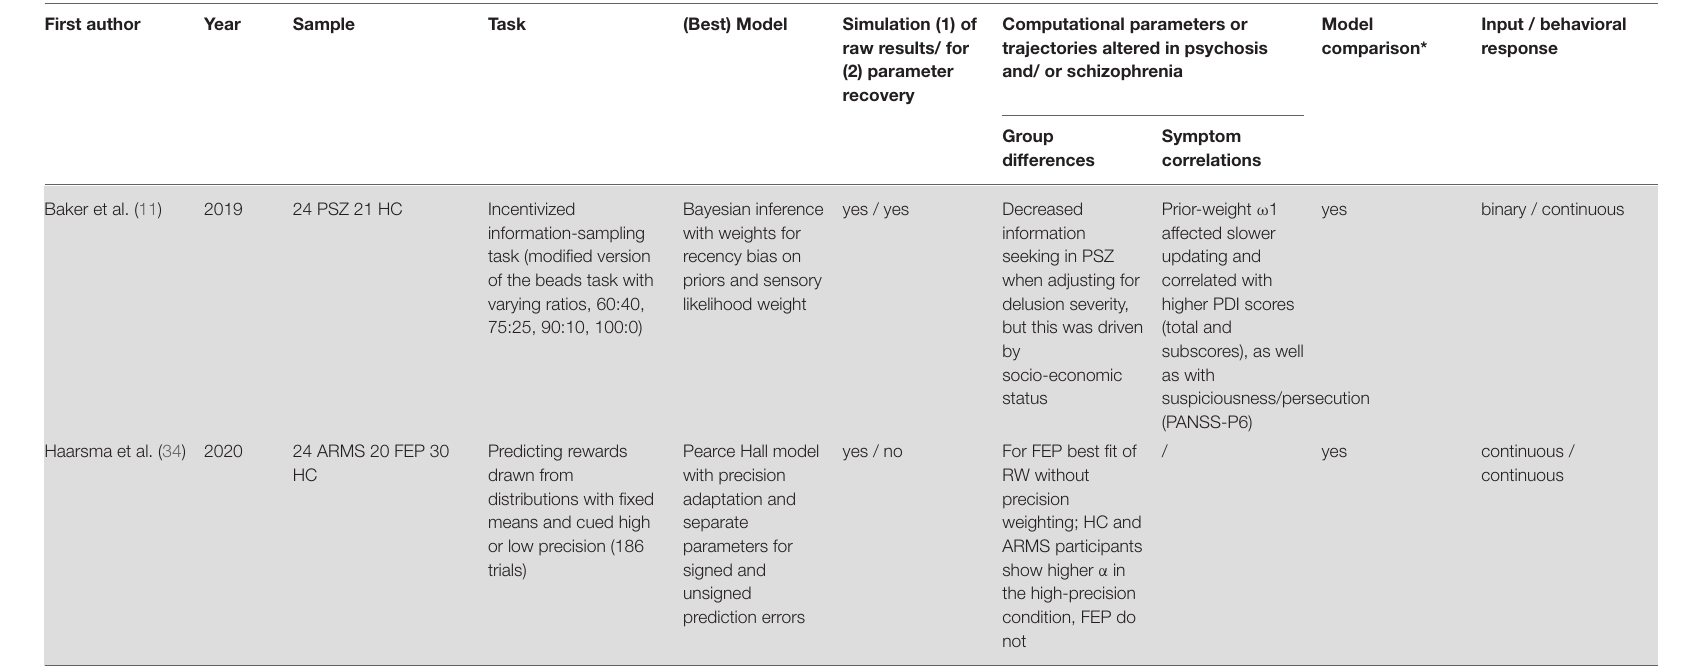
Hierarchical Gaussian Filter models in green, Change point detection modeling in yellow, Selection of various other dynamic models in grey. ARMS, At Risk Mental State; CHR, Clinical High Risk; FEP, First Episode Patients; HC, Healthy Controls; HP, High Paranoia; LP, Low Paranoia; PSZ, Patients with Schizophrenia; RLT, Reversal Learning Task; DU, Double Update; HGF, Hierarchical Gaussian Filter; HMM, Hidden Markov Model; RW, Rescorla-Wagner; V, Volatility; PANSS, Positive and Negative Syndrome Scale; PDI, Peters Delusion Inventory; Computational parameters or trajectories: α , learning rate; β , softmax temperature; δ , prediction error; k, 2 nd and 3 rd level coupling (HGF models); µ 3, dynamic volatility belief; ω , constant component of 2 nd level belief update/evolution rate; ϑ , meta-volatility; m3; mean-reversion equilibrium; * Model selection in terms of formal comparison between quantitative model fit